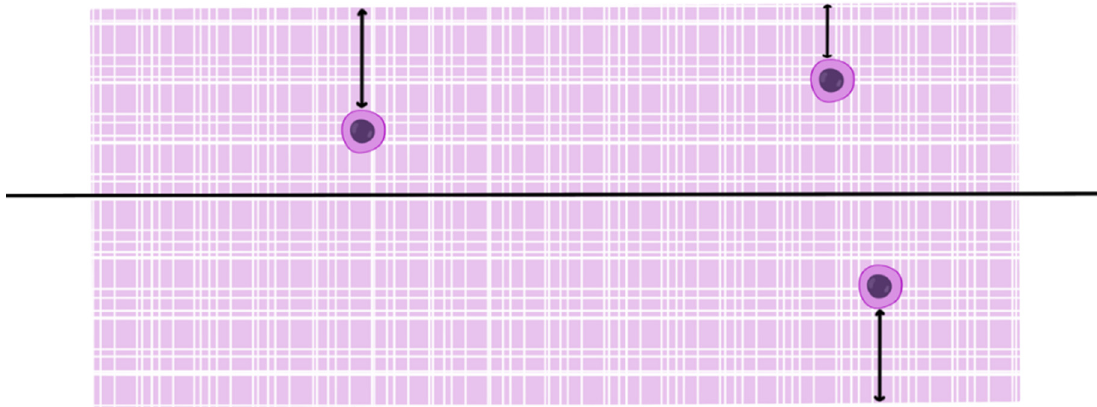
Figure 1. Schematic illustration of the histomorphometrical analysis of the cellular penetration depth measurements of the membranes. The membranes (checkered area) were divided into two approximately identical examination areas (black line) to measure the respective migration of cells from both material surfaces (double arrows) for calculation of the percentage migration depth of the cells.